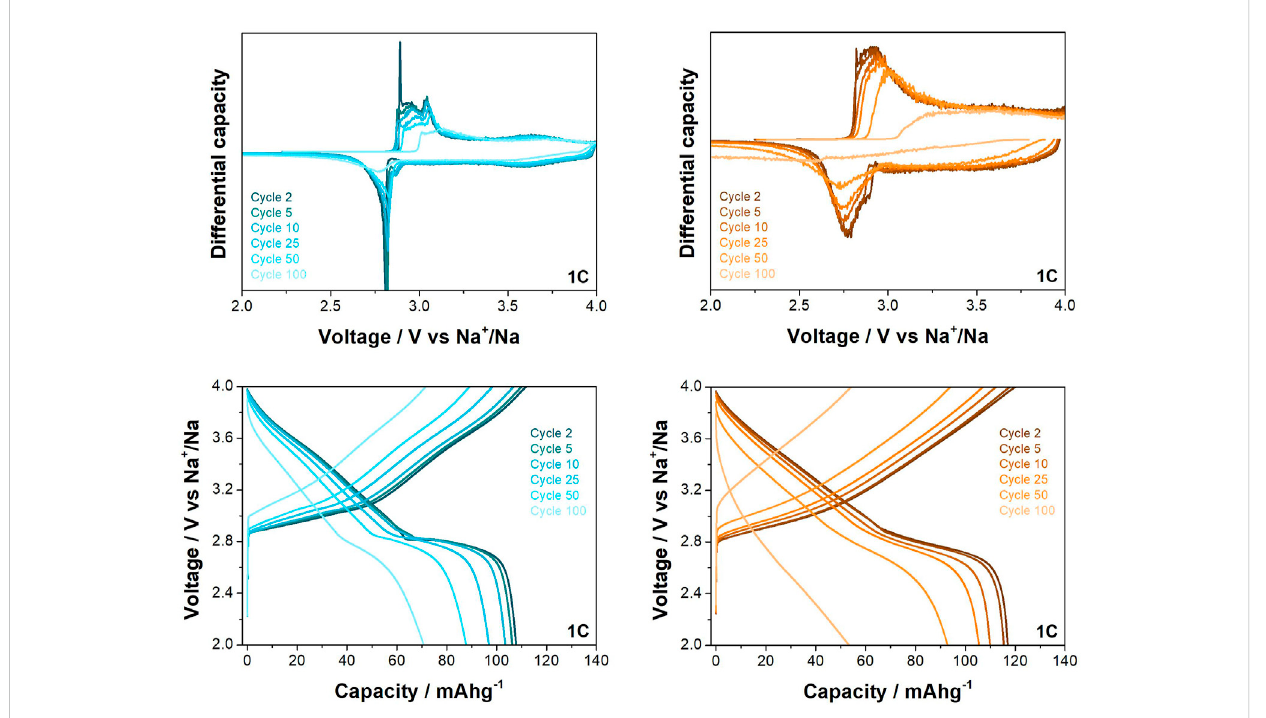
FIGURE 6 Differential capacity plots and load curves for O3-NaNMFO-SS (dark turquoise) and O3-NaNMFO-SG (orange) at